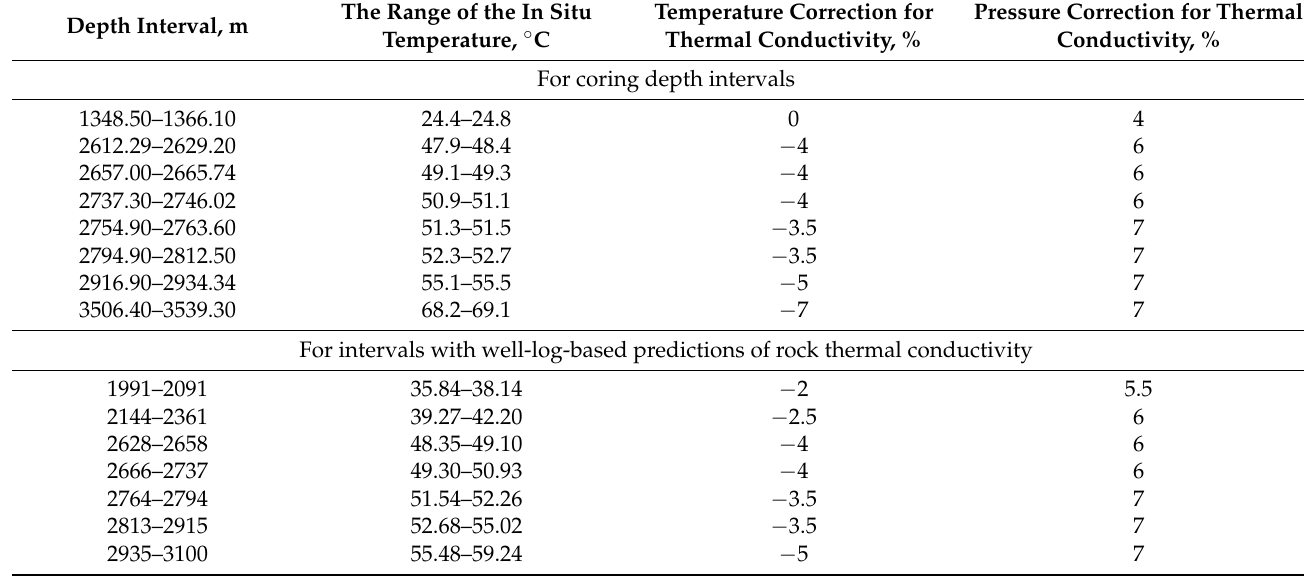
Table 7. Temperature corrections for thermal conductivity that were obtained from measurements with DTC-300 and pressure corrections for thermal conductivity that were inferred from literature data [30,31], for coring depth intervals and for depth intervals with well-log-based predictions of thermal conductivity.